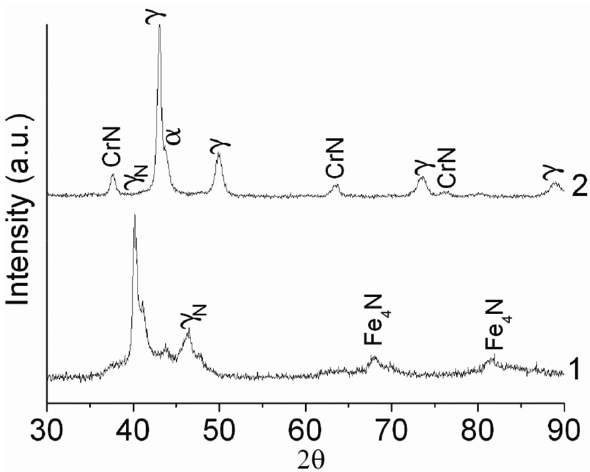
Figure 9: X-ray diffraction patterns: 1 − 60 min, – 750 V, 2.0 mA/cm 2 , 530°C. 2 − 20 min, – 500 V, 3.3 mA/cm 2 ,